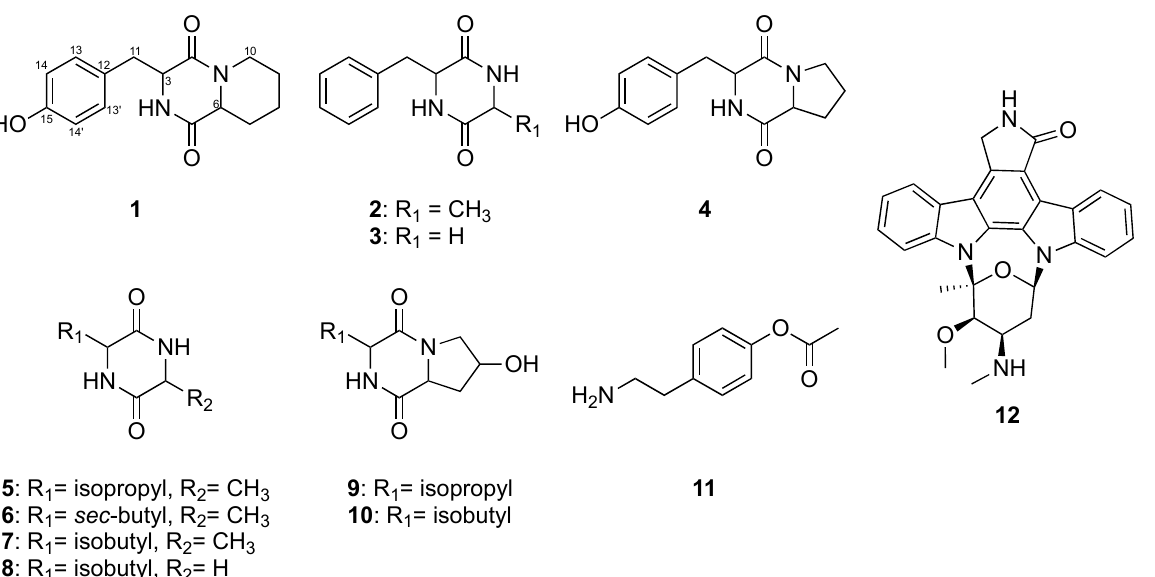
Figure 1. High-resolution anti-proliferative profile of the ethyl acetate (EtOAc) extract (1 μ g/mL) of Streptomyces sp. LY1209 against Molt 4 cells.